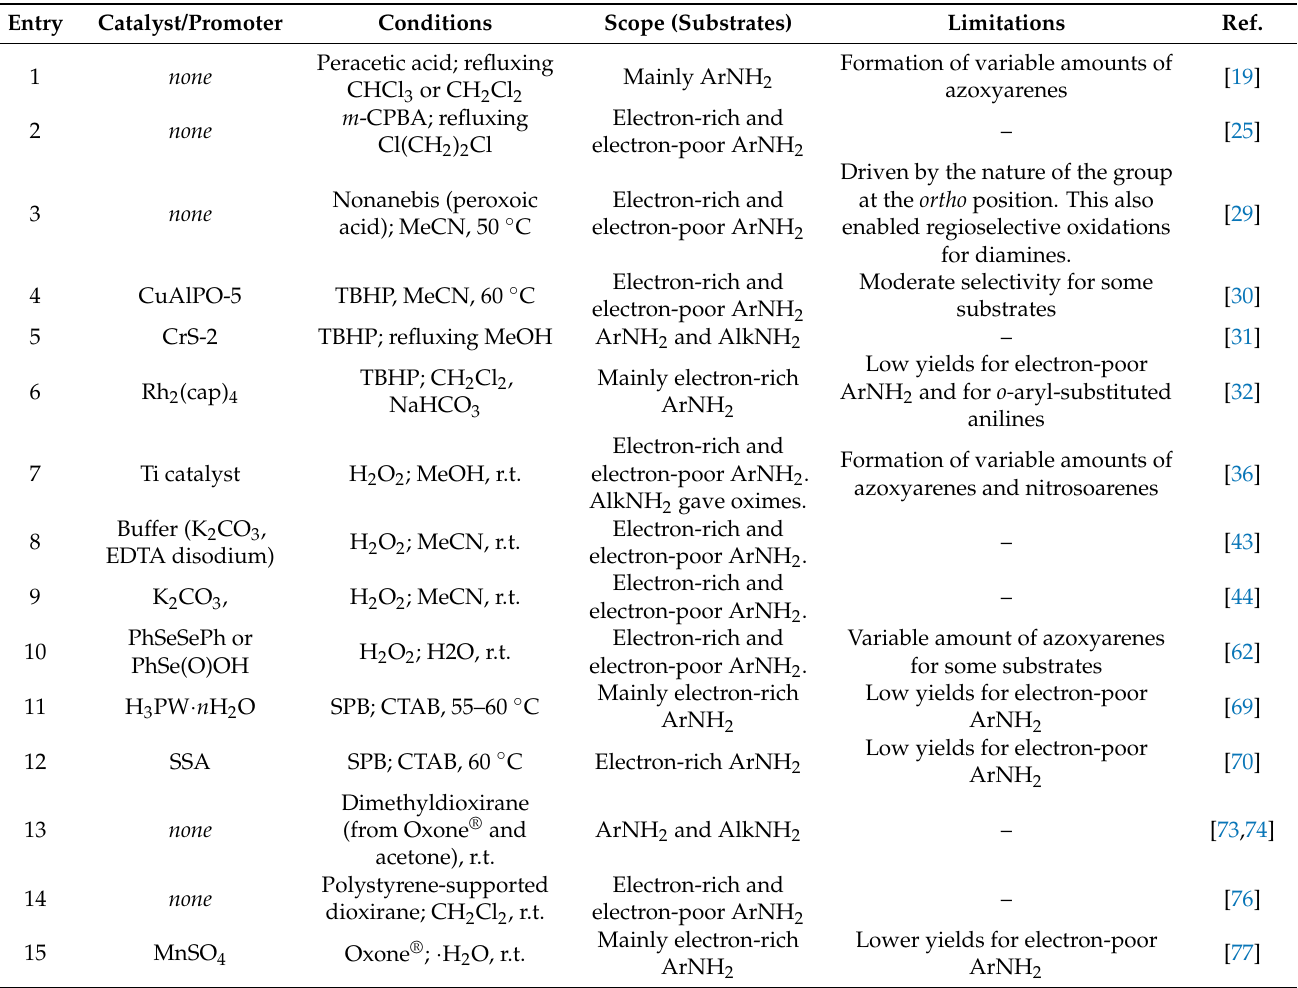
Table 1. Synthetic overview of methodologies for the oxidative conversion of amines to nitro